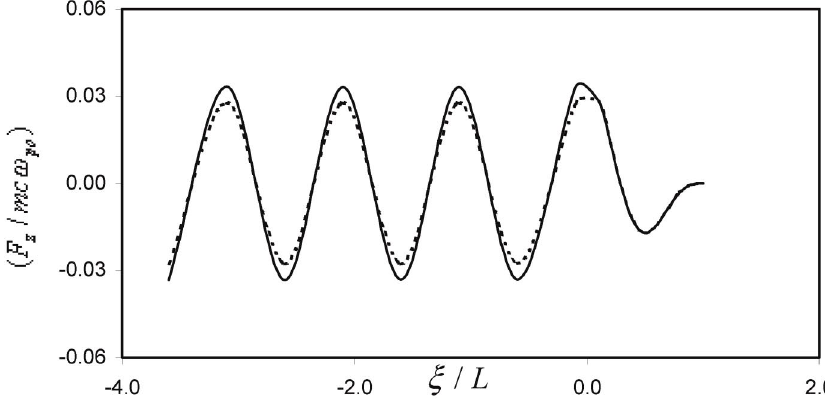
1. Normalized axial force (cid:3) F and in a homogeneous plasma (dashed curve) for a 2